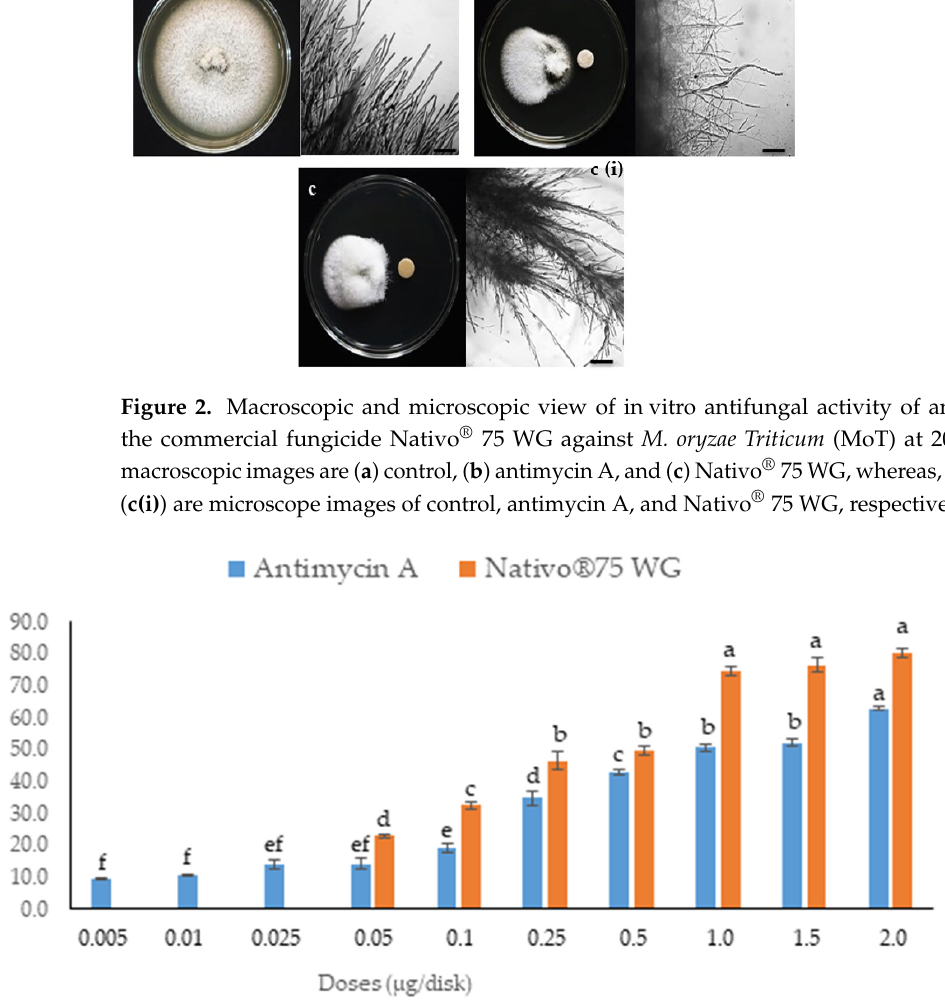
Figure 3. Inhibitory effects of antimycin A and the commercial fungicide Nativo ® 75 WG on mycelial growth of MoT in PDA media. The data are the mean ± standard errors of five replicates for each concentration of the compound tested at a 5% level based on the Tukey HSD (Honest Significance Difference) post-hoc statistic. Bars having a common letter are not significantly different at the 5% level of significance.